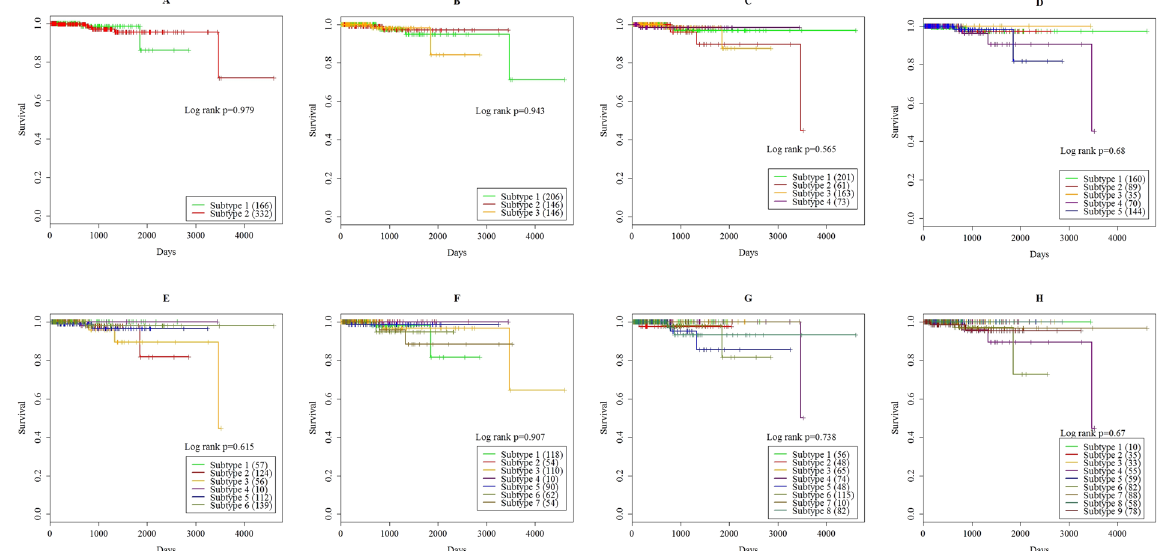
Figure 3. Survival curves of 498 tumor patients with respect to the ( A ) 2 subtypes, ( B ) 3 subtypes, ( C ) 4 subtypes, ( D ) 5 subtypes, ( E ) 6 subtypes, ( F ) 7 subtypes, ( F ) 8 subtypes, ( G ) 9 subtypes. The numbers in the brackets indicated the corresponded number of samples for this subtype. As shown in this figure, no statistically significant difference was found by the log-rank tests. This is because at this time, the follow-up time of this cohort remains very limited, when additional follow-up data are available in the future time, it is possible that the differences will become